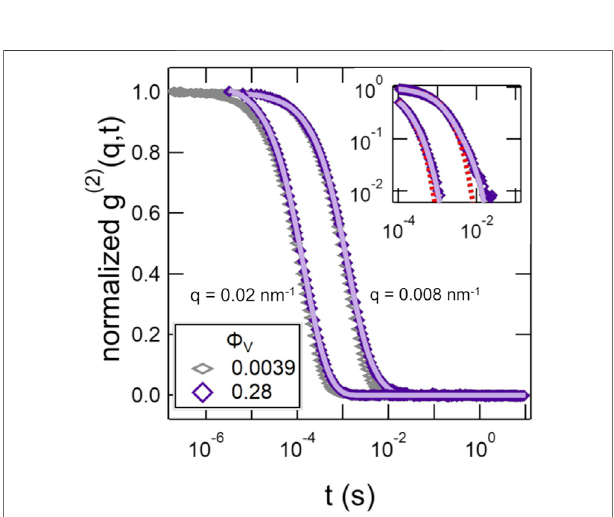
FIGURE 3 | Normalized intensity-intensity correlation functions, g (2) ( q , t ) at two representative q values for SOPC vesicle solutions with lipid mass fractionsof ϕ V =0.0039and 0.28.Thesolidlines arethe fi tstothedataat ϕ V = 0.28 with a double exponential decay using Eq. 8 . The inset is the data for ϕ V = 0.28 plotted on a log-log scale and compares the fi ts with a single (dotted line) and double exponential (solid line) decay.